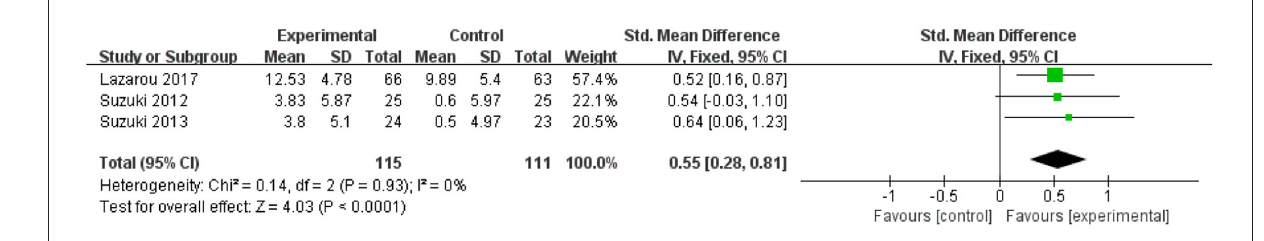
FIGURE5 The influence of exercise interventions on immediate recall.